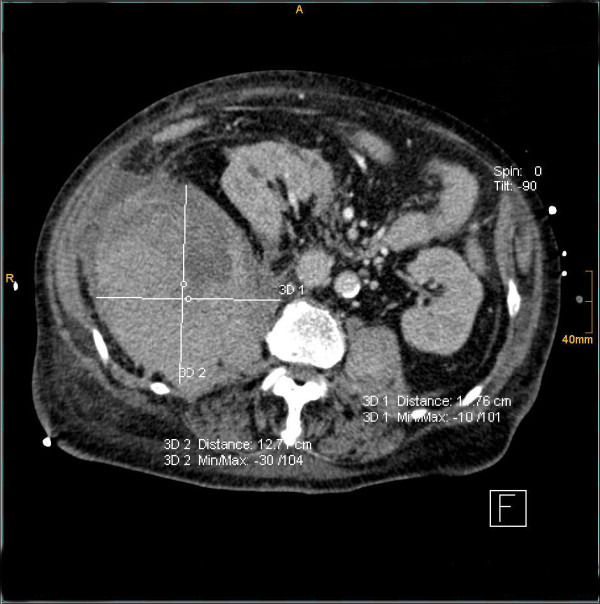
3rd case. CT - axial plan of the hematoma.